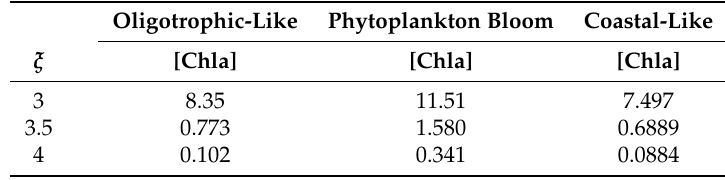
Table 7. Total chlorophyll-a concentration for the three case